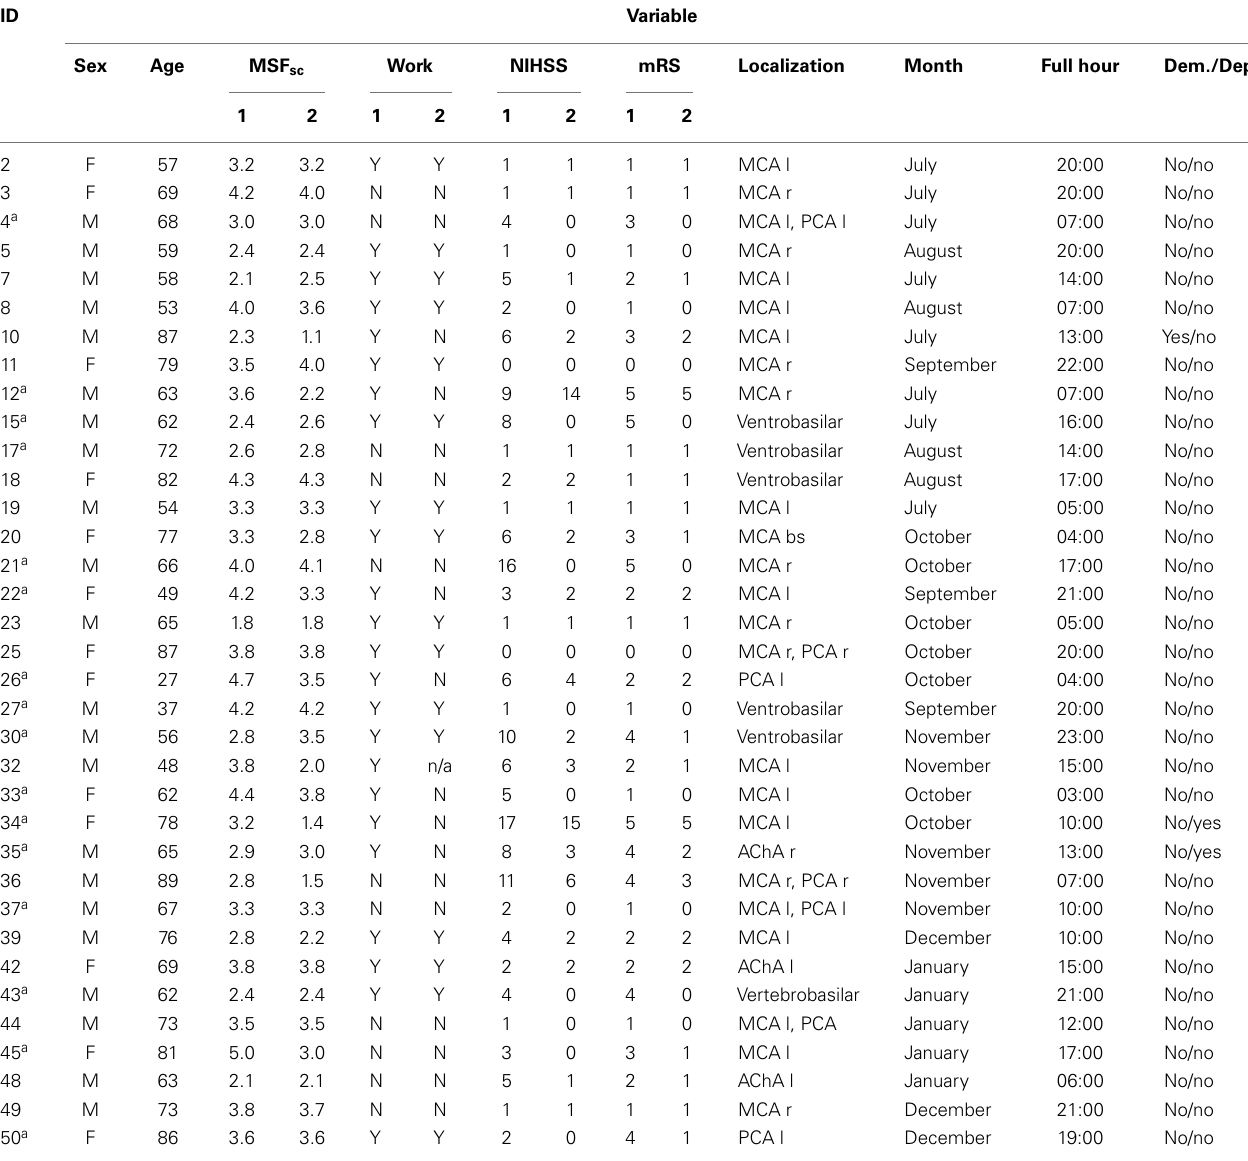
Table 1 | Characteristics of all 35 stroke patients at time point of study participation/hospital admission